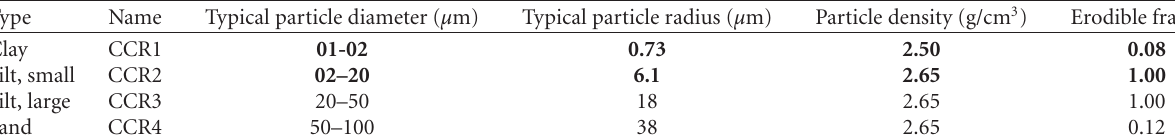
Table 1: Features of the four typical dust particles.